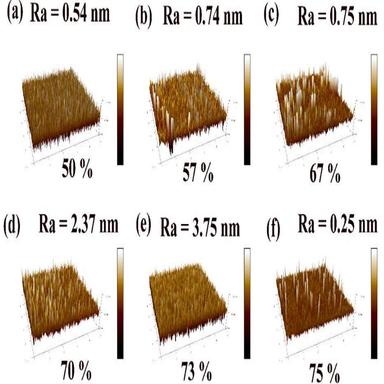
AFM 3D images of chromium oxide films deposited at different oxygen partial pressures. Image a) shows the morphology at 50 % oxygen partial pressure, followed by images b), c), d), e), and f) which display morphologies at 57 %, 67 %, 70 %, 73 %, and 75 % oxygen partial pressures, respectively.